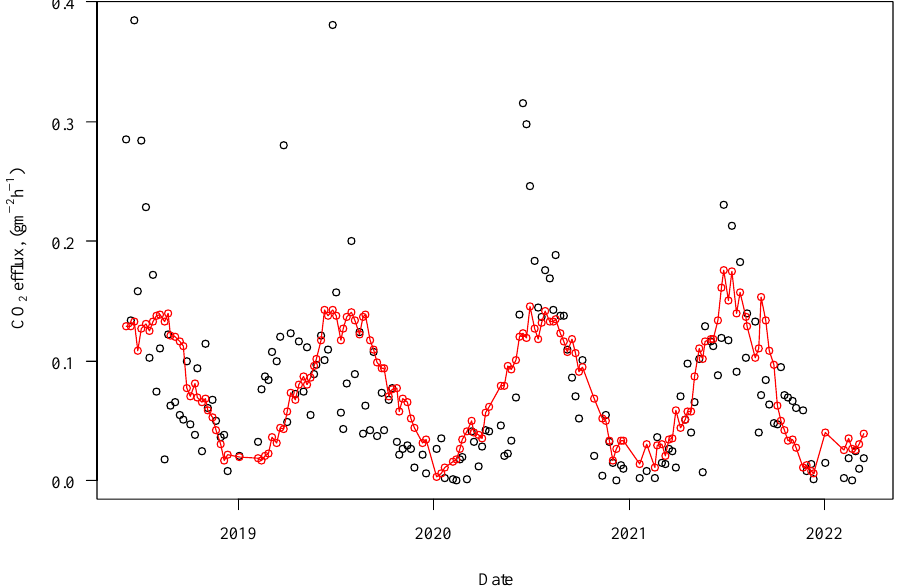
Figure 4. Outputs of the linear model for the CO 2 efflux (g m − 2 h − 1 ) from undisturbed bare soil within the period of 2018–2022. Measured and calculated data are represented by black and red circles, respectively.